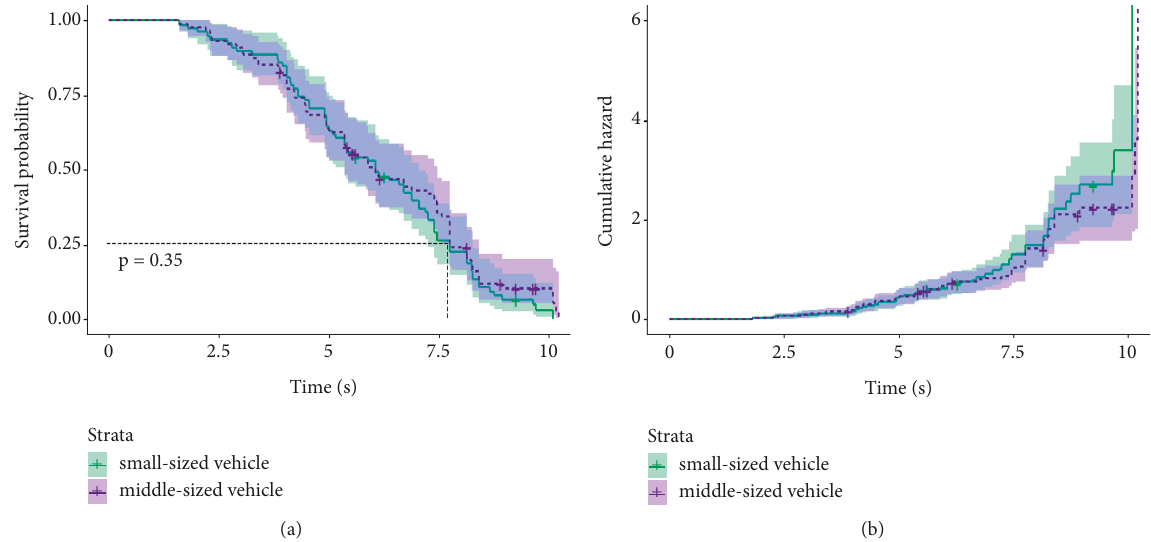
, Δ T , Δ T , respectively, are average time 1 2 3